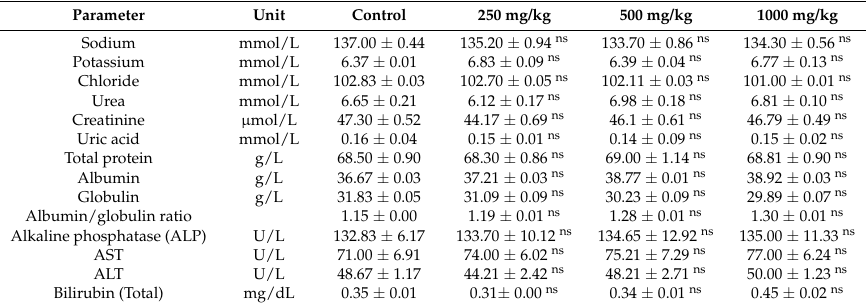
Table 7. Effect of MTE on biochemical parameters in the subacute oral toxicity study.